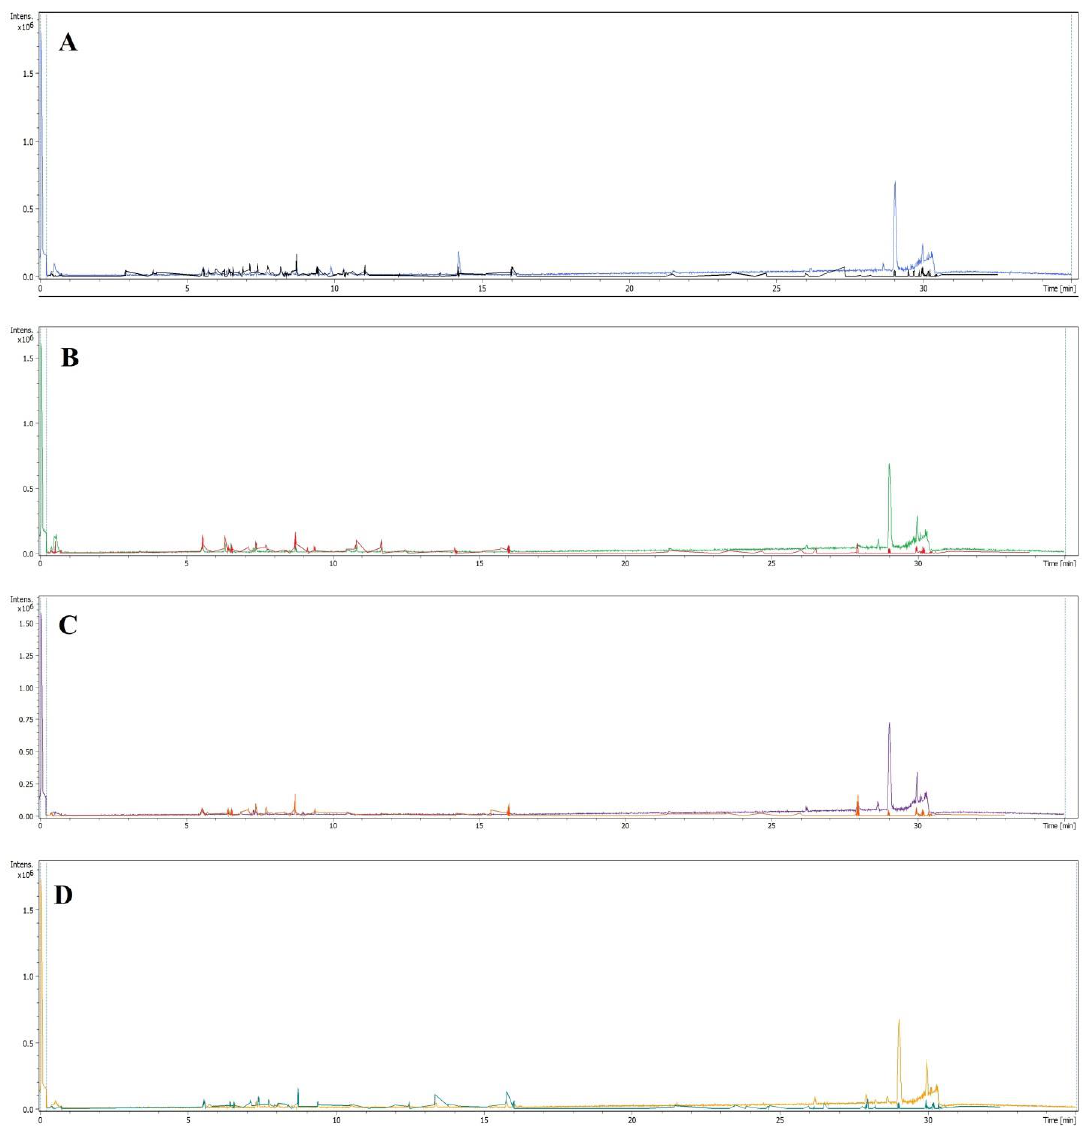
Figure 1. LC-MS chromatograms of the four halophytic plants; ( A ) R. vesicarius , ( B ) L. shawii , ( C ) A. articulata, and ( D ) Z. spinosa. Chromatographic analyses also exhibited that the total percentages of the identified compounds from each plant were 30.07 %, 21.99 %, 19.15 %, and 22.41 % for R. vesicarius , L. shawii , A. articulata, and Z. spinosa , respectively, based on the compounds ’ discernible peaks as available in their respective LC-chromatograms. The presence of these com- pounds in the plants also revealed their health benefits as saccharides and fatty acids, together with the phenolics and flavonoids classes of compounds, which were present in abundance in these plants ’ extracts. The presence of the saturated fatty acids, e.g., stearic acid, at higher proportions in the extracts of all the plants (from 6% to 11% of the identi-